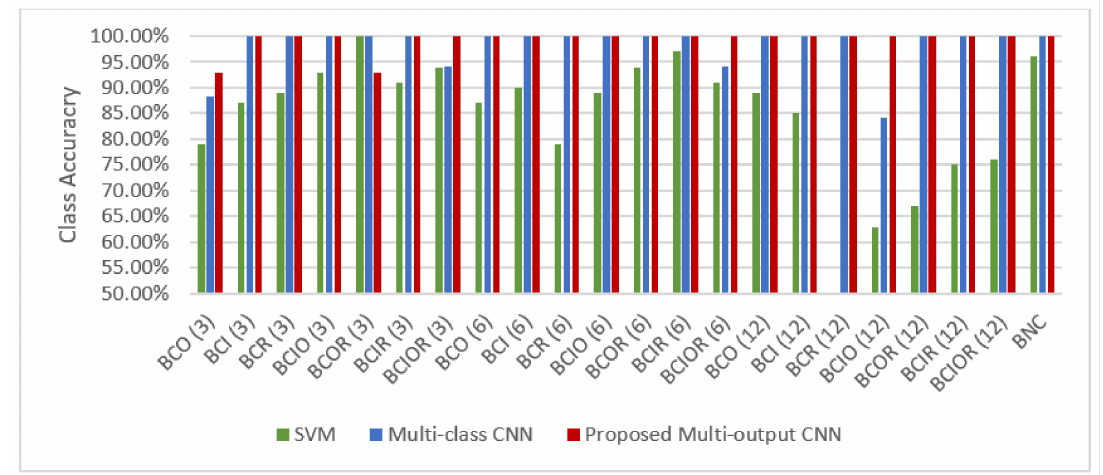
Figure 6. Diagnosis comparison for SVM-based method and two CNN-based